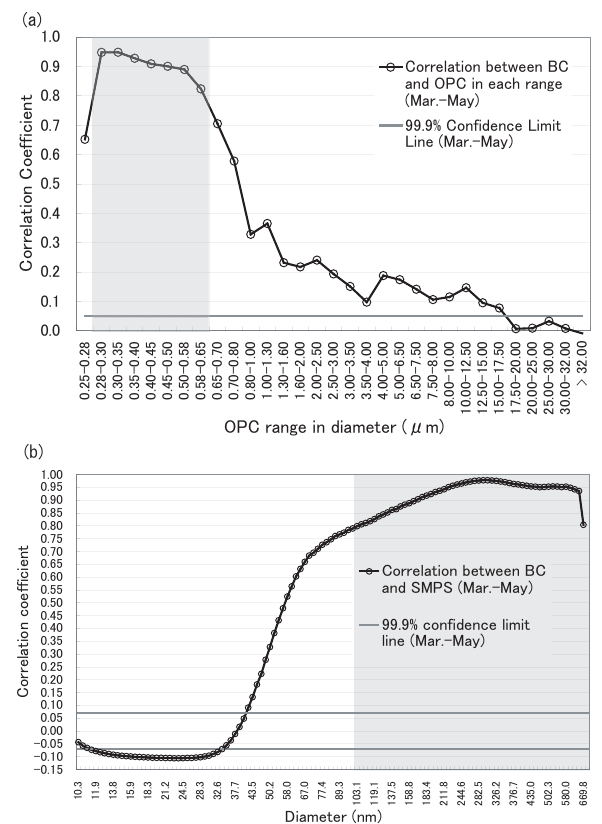
Fig. 2. Correlation coefficients (black solid line with circle) for March–May in time series data between atmospheric eqBCC and (a) particle counts in each size (as measured by OPC); (b) (as mea- sured by SMPS). The bold line in gray denotes 99.9% confidence limit lines. The shade size ranges correspond to the correlation co- efficient of more than